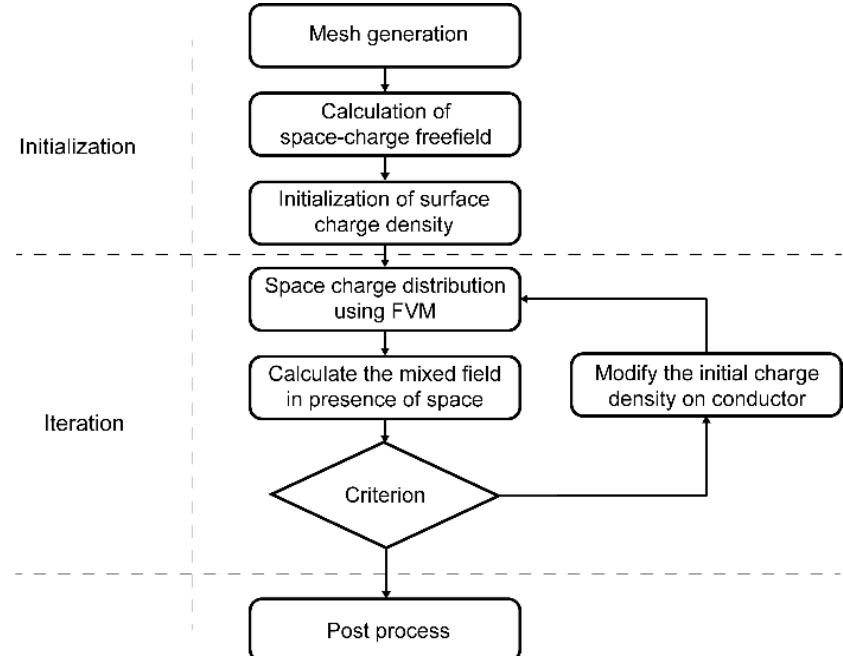
Figure 1. Flowchart of the method.